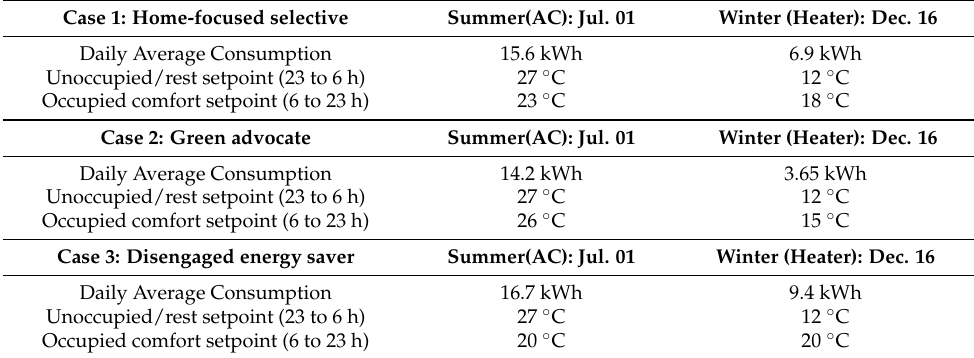
Table 4. Heating and cooling designs with different